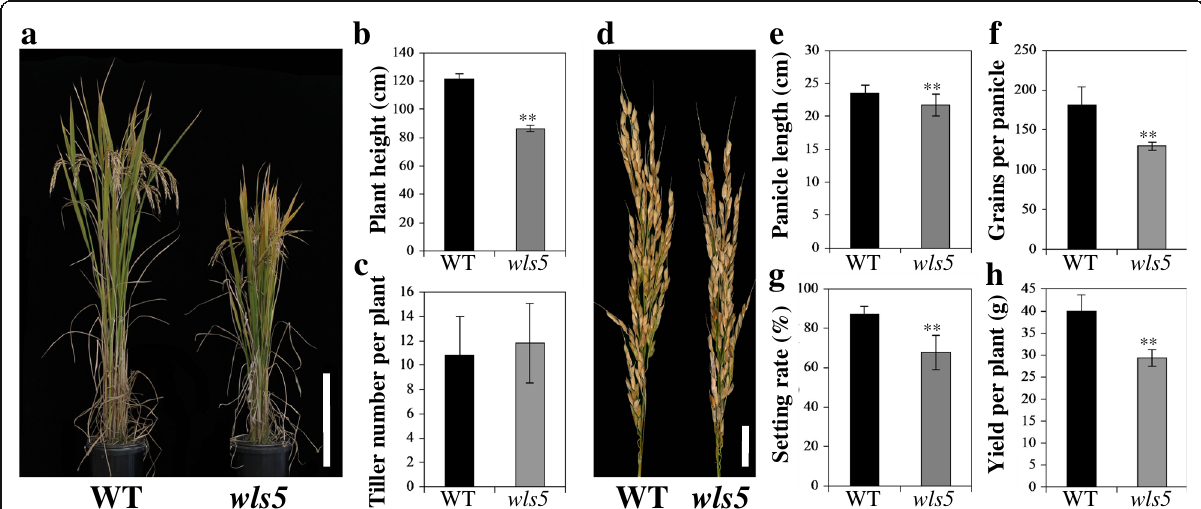
Fig. 1 Phenotypic comparison between wild-type (WT) and wls5 plants. a WT ( ‘ 93 – 11 ’ ) and wls5 plants at maturity. Bar = 40 cm. b , c Statistical analysis of plant height and tiller number between WT and wls5 plants. Twenty plants were measured. Error bars indicate SD; ** P < 0.01 (Student ’ s t- test). d Panicle phenotype of WT and wls5 plants. Bar = 3 cm. e - h Statistical analysis of panicle length, grains per panicle, setting rate and yield per plant between WT and wls5 plants. Twenty panicles were measured. Error bars indicate SD; ** P < 0.01 (Student ’ s t